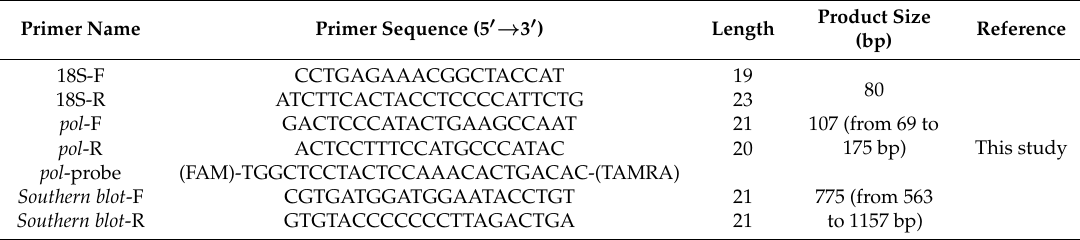
Table 2. Primers used in qualitative and quantitative